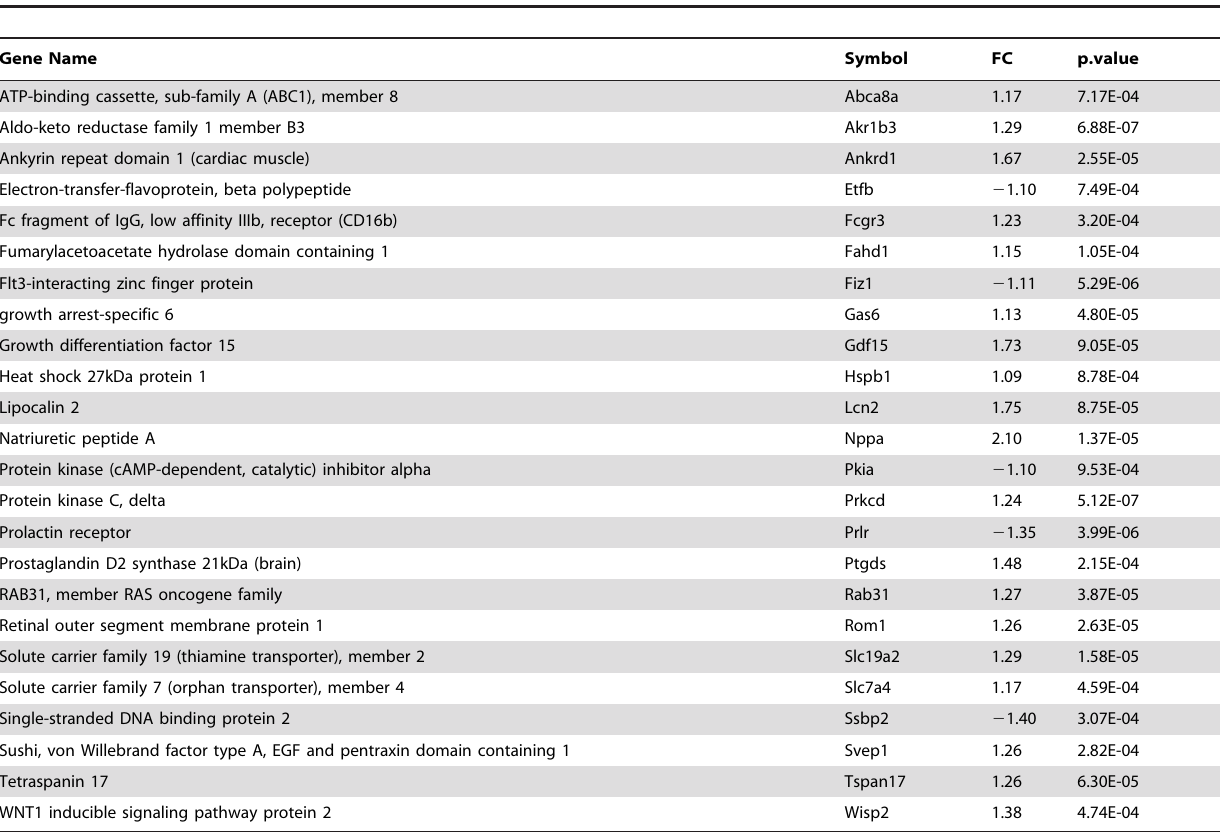
Table 4. List of significantly different genes (P , 0.05, 2-Way ANOVA) between cs-ER a 2 / 2 and Wild type mice and networked directly to ER a